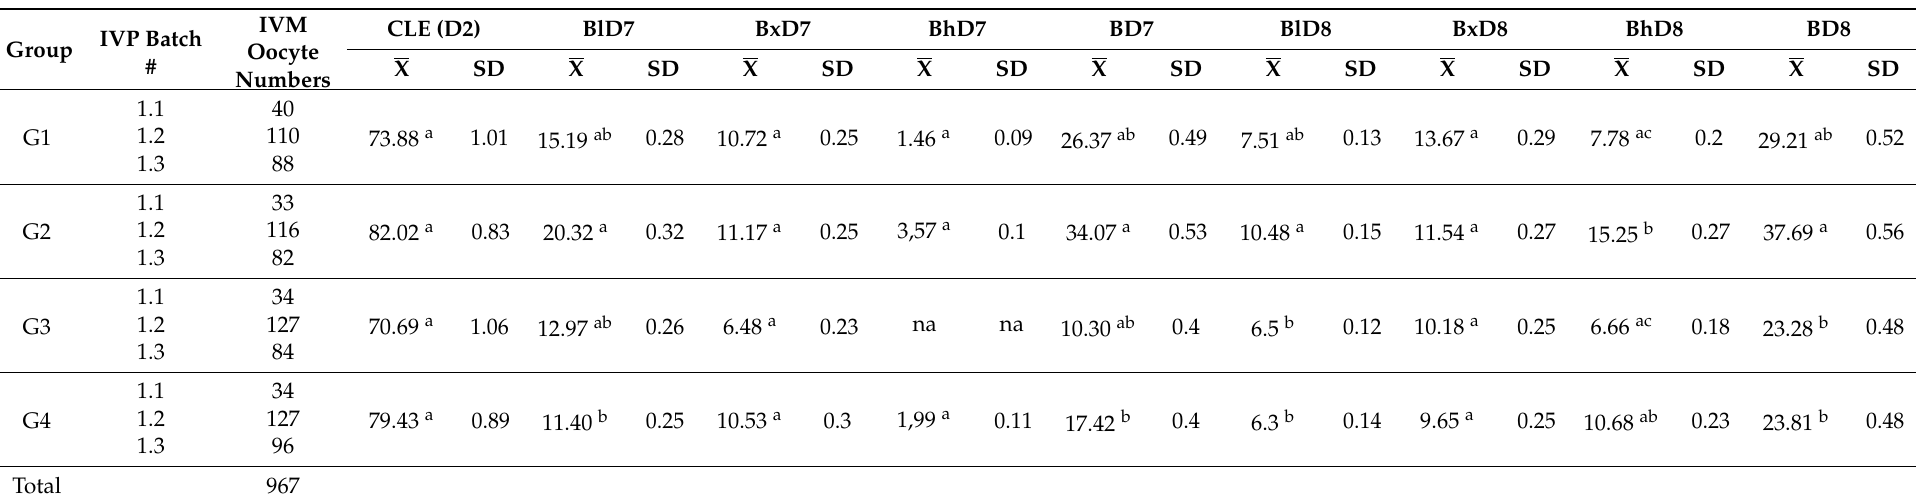
Table 1. Numbers (n) and percentage ratios of embryonic development parameters (CLED2; BlD7; BxD7, BhD7, BD7, BlD8, BxD8, BhD8, and BD8. All percentage ratios were calculated using the IVM oocyte number for each IVP replicate. CLED2 was evaluated 36 to 48 h after IVF and after 7 (D7) and 8 days (D8) of IVM cultivation to compare the 4 treatment groups (G1, G2, G3, and G4) and 3 IVP replicates (1, 2, and 3) used in Experiment 1 (IVM medium supplementation with test items at different concentrations for each treatment